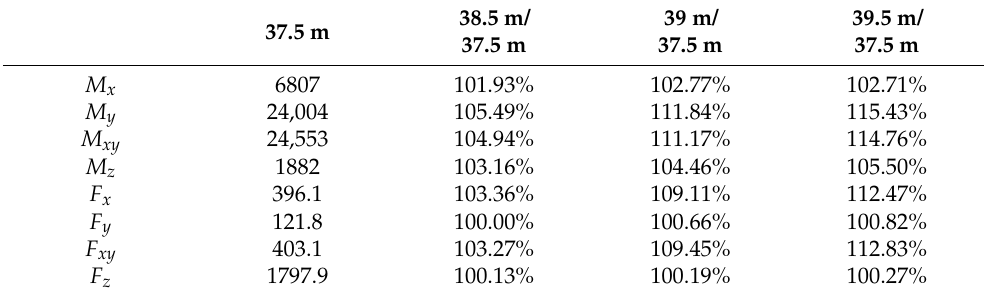
Table 11. Ultimate loads at tower bottom.